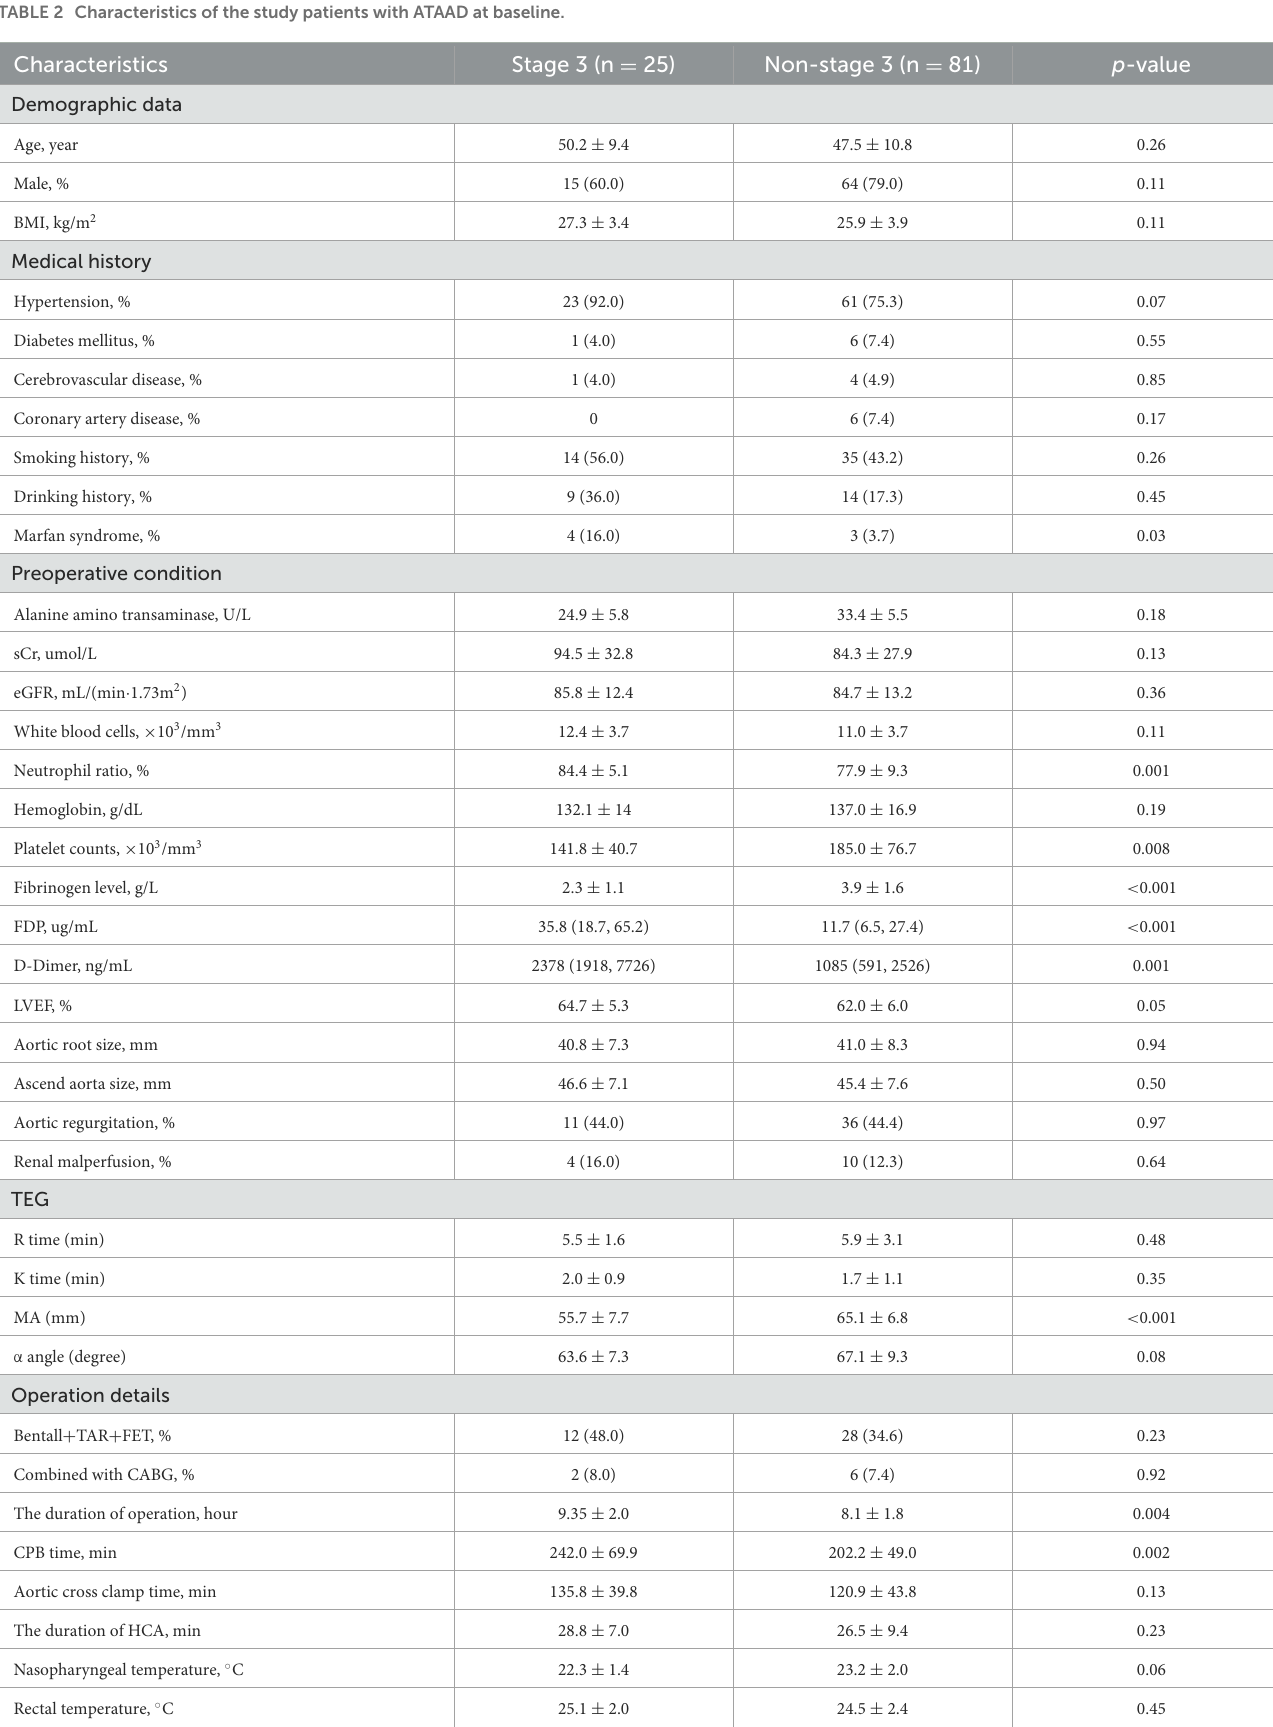
TABLE 2 Characteristics of the study patients with ATAAD at baseline.